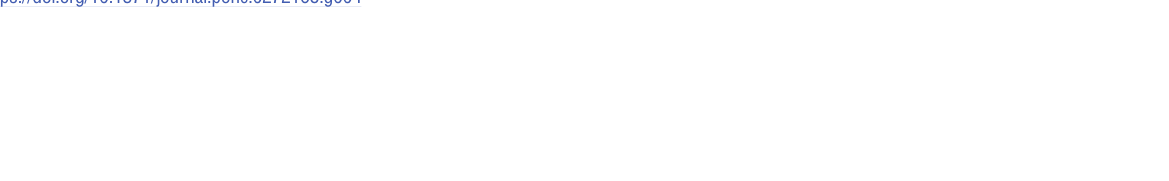
PLOS ONE | https://doi.org/10.1371/journal.pone.0272168 August 2,